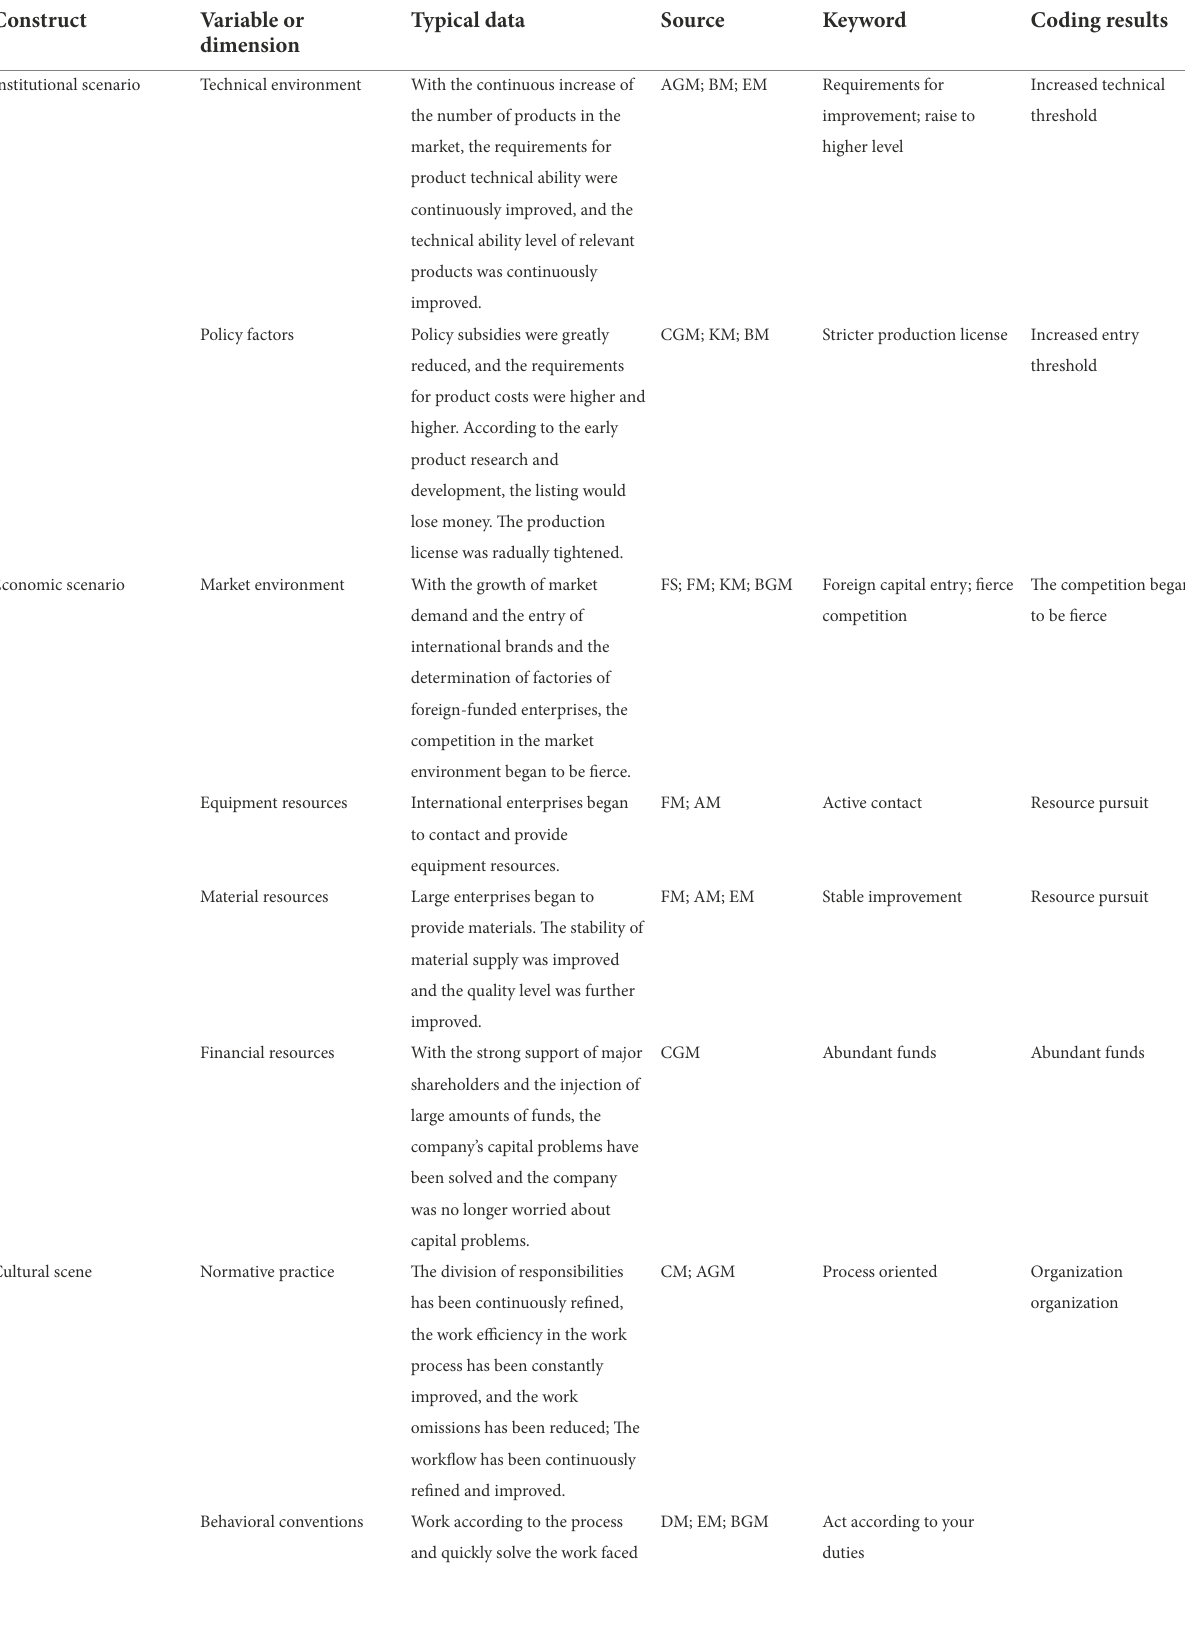
TABLE 7 Cited examples and coding results in phase